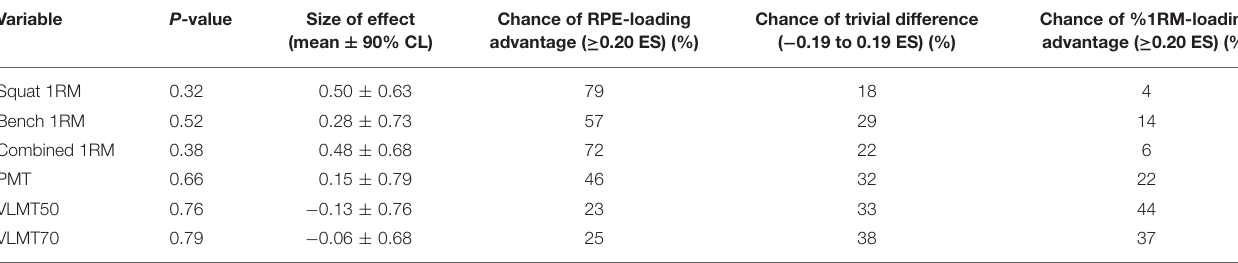
TABLE 4 | Strength and muscle thickness changes.